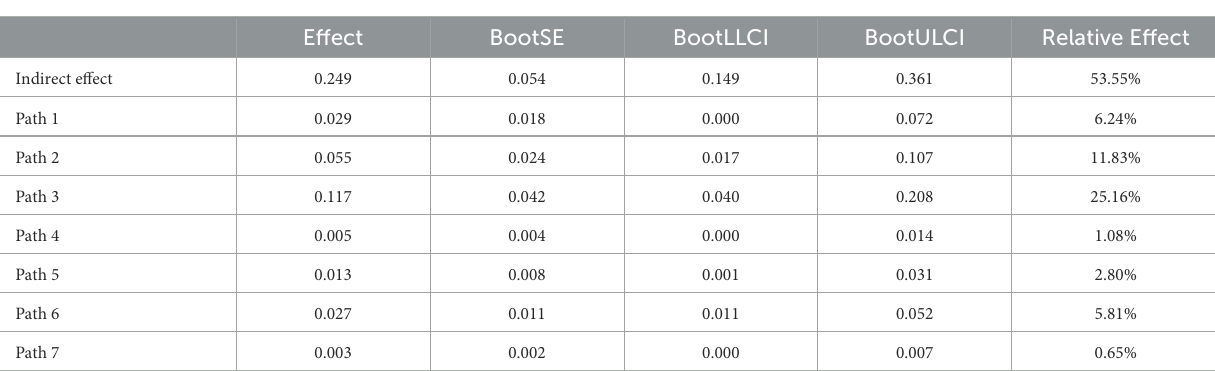
TABLE 3 The results of the mediating